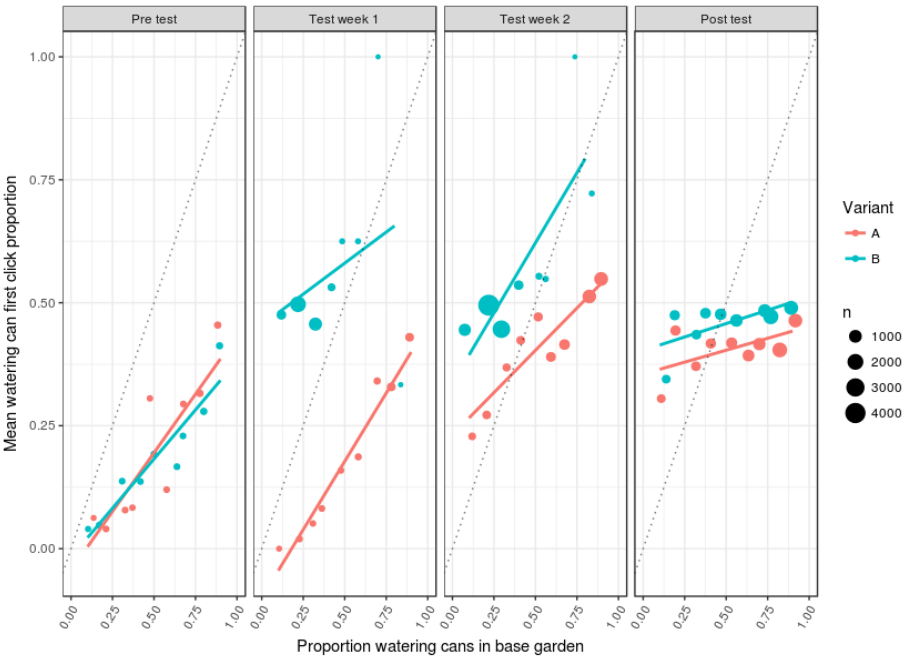
Figure 3. First click rates per A (control) and B (experimental) test condition, per test week. Points above the diagonals (dotted) indicate an average attraction to the watering can domains, points below the diagonal an average avoidance of watering can